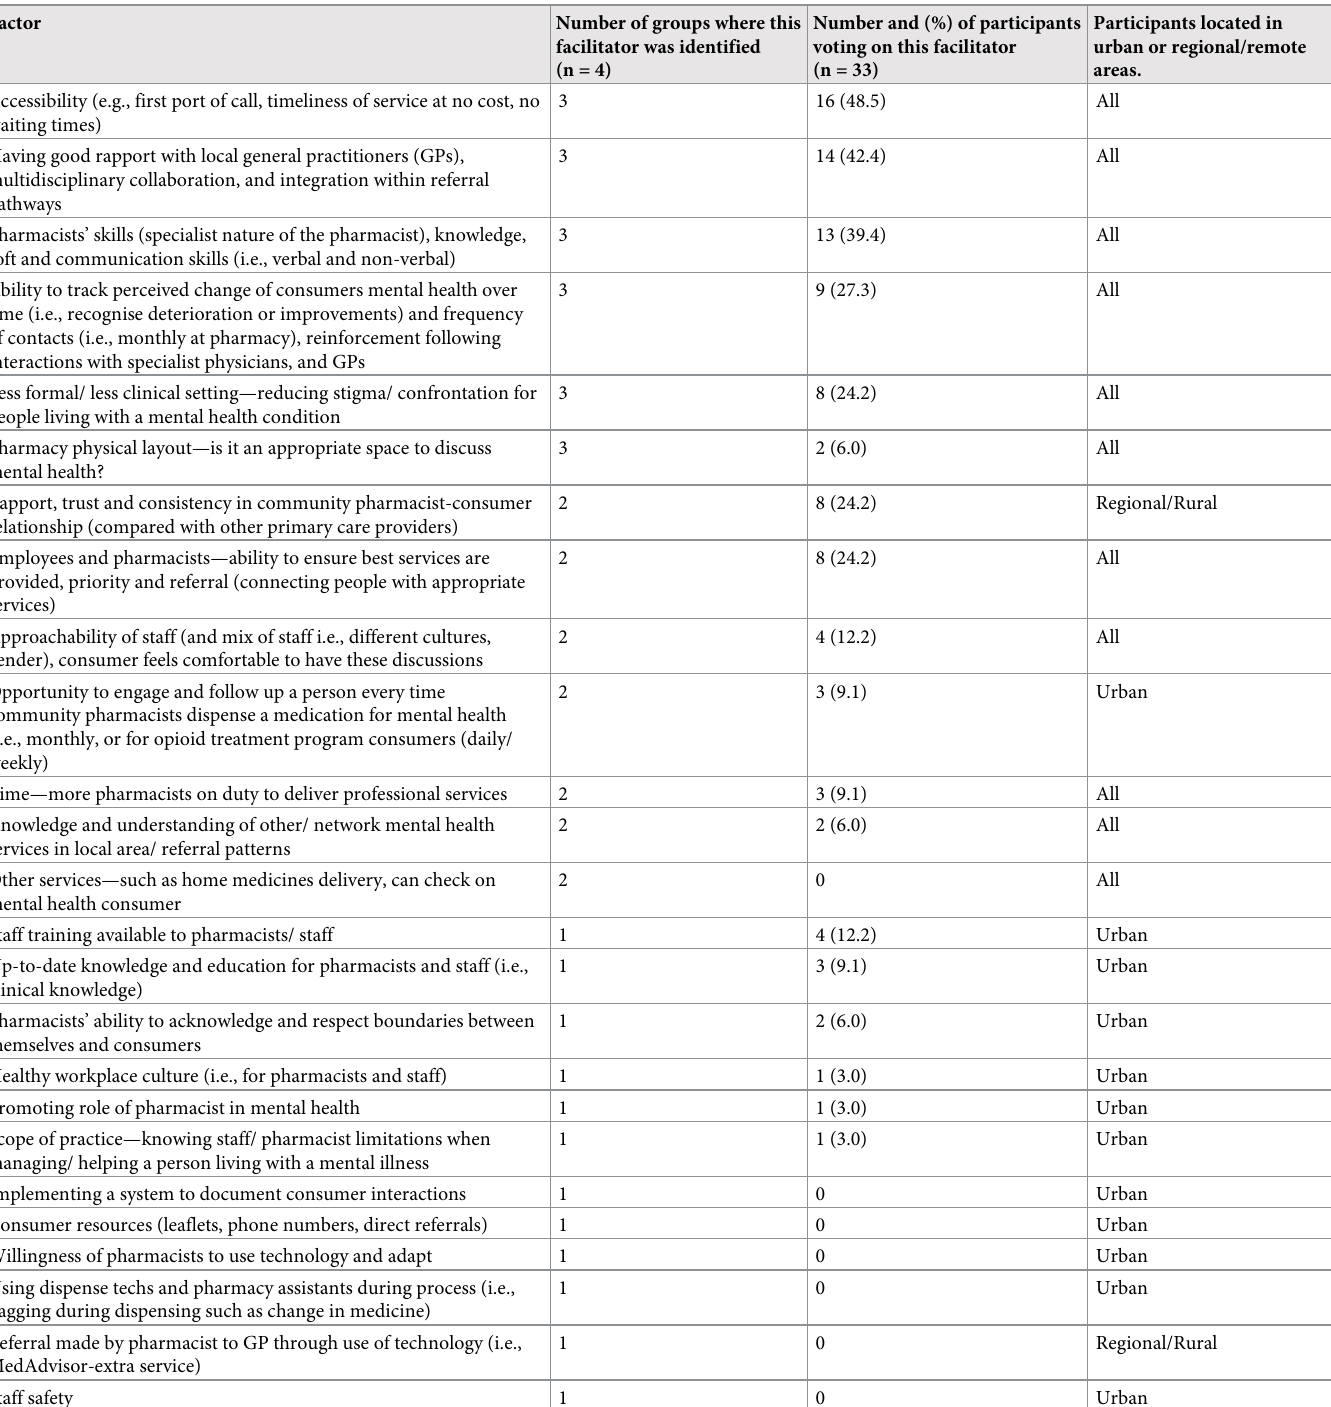
Table 3. Factors identified as facilitators of mental health service delivery in community pharmacy. Factor Number of groups where this facilitator was identified (n = 4)